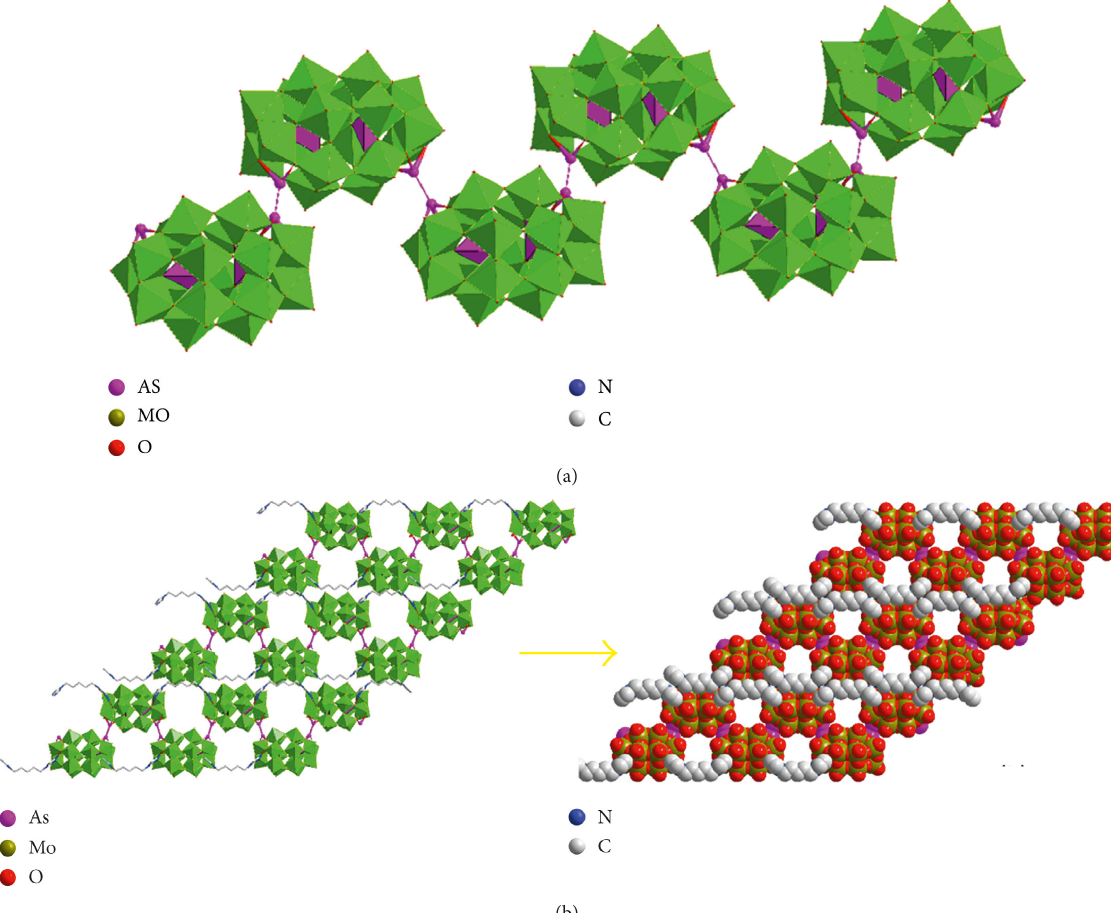
Figure 3: (a) The picture with ball-stick and polyhedral fashion shows the 1D chain of 2 by hydrogen bonds; (b) 2D layered framework of 2 formed by hydrogen bonds.